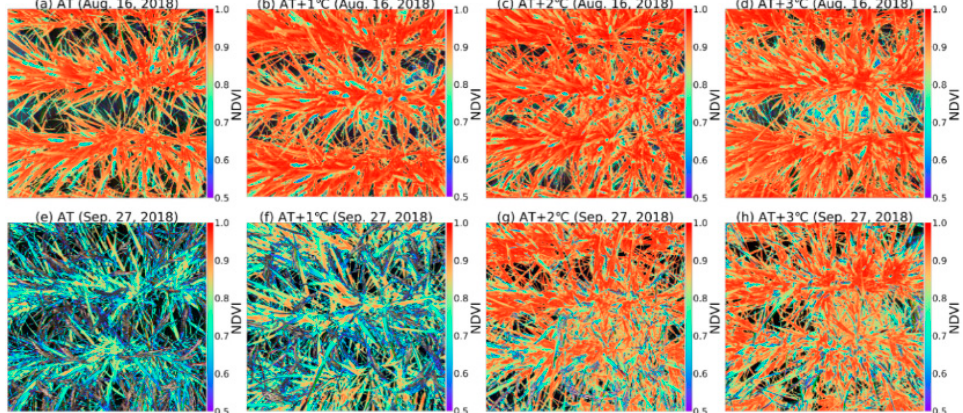
Figure 11. NDVI images for paddy rice measured by the multi-spectral camera on 16 August 2018 (heading stage) ( a – d ) and 27 September 2018 (harvesting stage) under different air temperature conditions ( e – h ). Color is observed when NDVI is above 0.5.